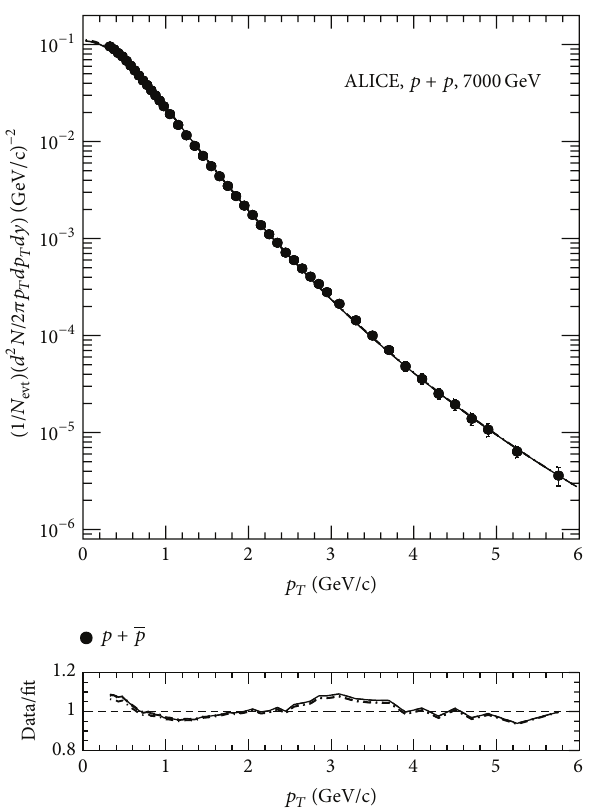
Figure 4: Same as in Figure 1 for 𝑝 + 𝑝 in 𝑝 + 𝑝 collisions at √𝑠 = 7000 GeV. Data are taken from ALICE